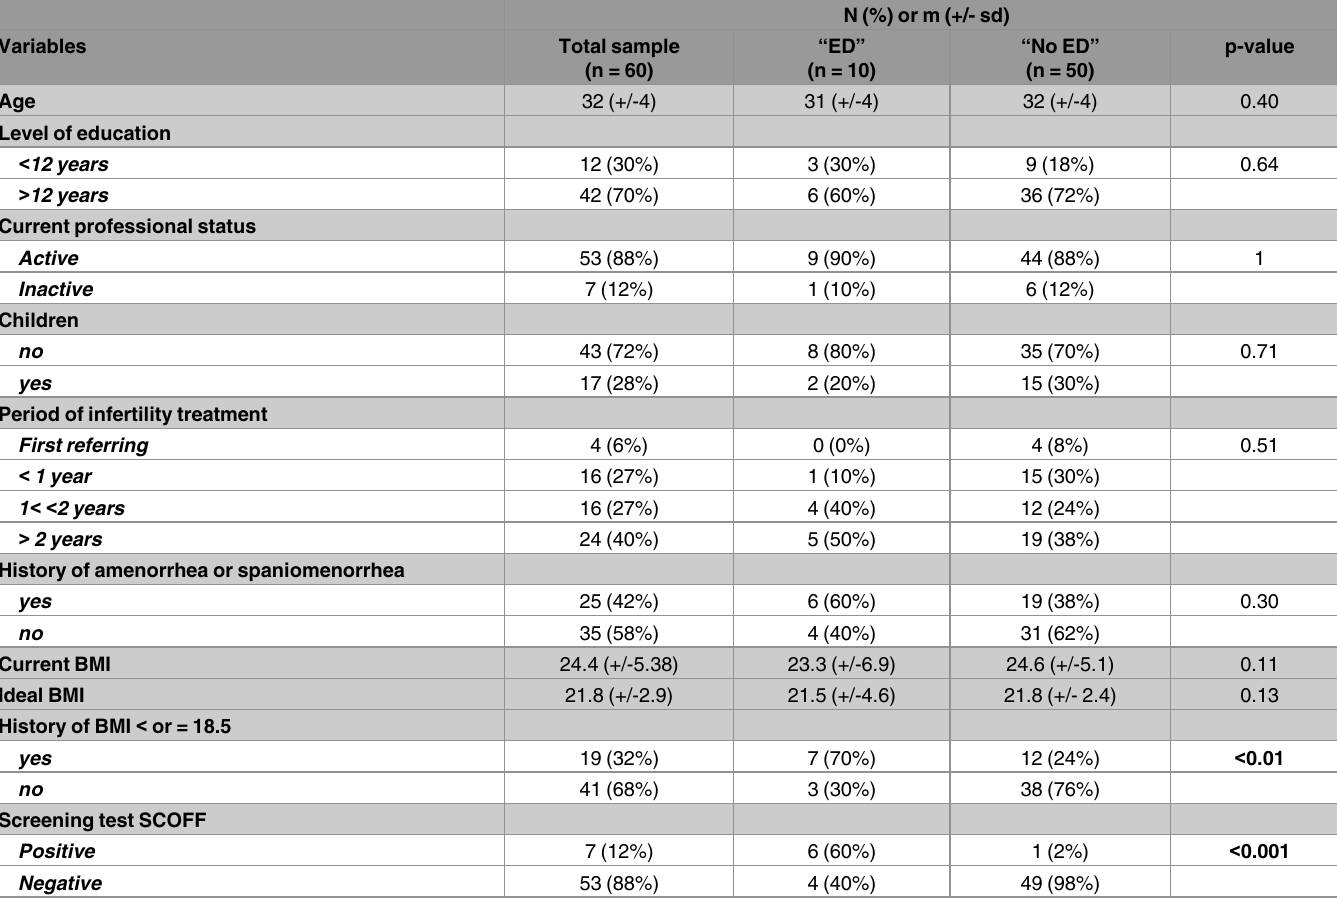
Table 1. Comparaison of “ED” and “No ED” groups, according to the sociodemographic, infertility and eating